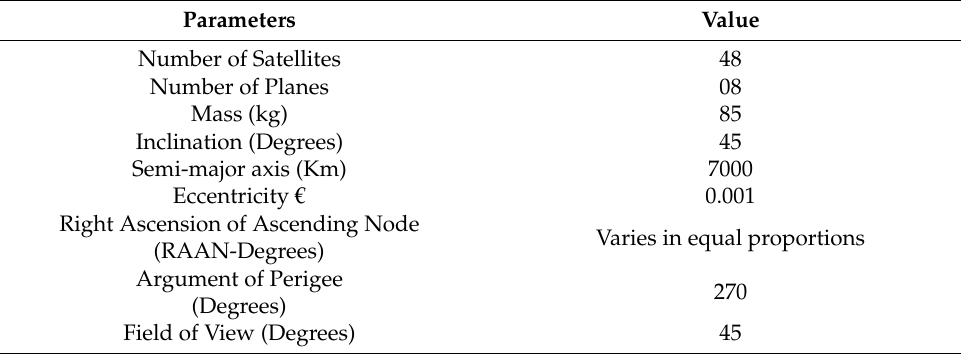
Table 1. Specifications of the small satellite